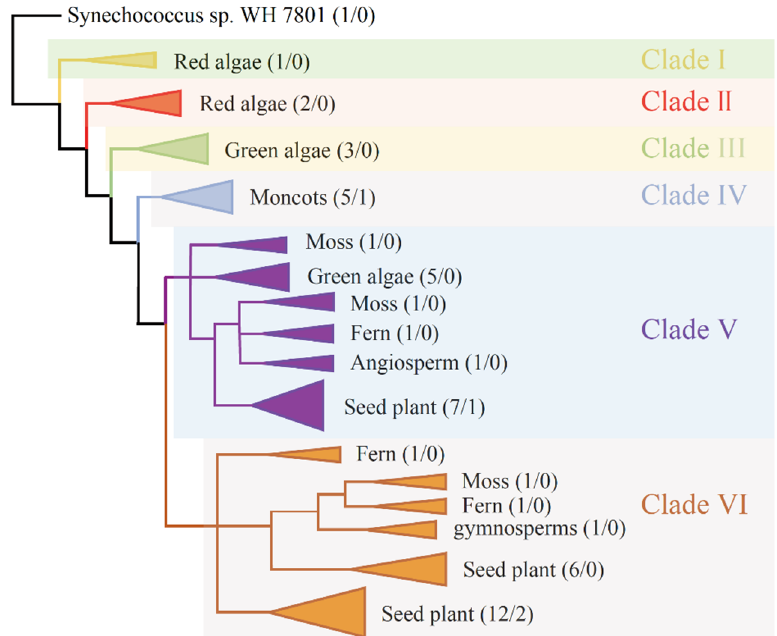
Figure 7. A phylogenetic tree of 50 SAT proteins from 16 species. The phylogenetic tree drawn by SAT protein sequences is divided into six clades (I, II, III, IV, V and VI) with different colors. Two numbers in parentheses represent the number of SAT proteins from all analyzed species and only from maize. The cyanobacteria of Synechococcus sp. WH 7803 is used as a root.